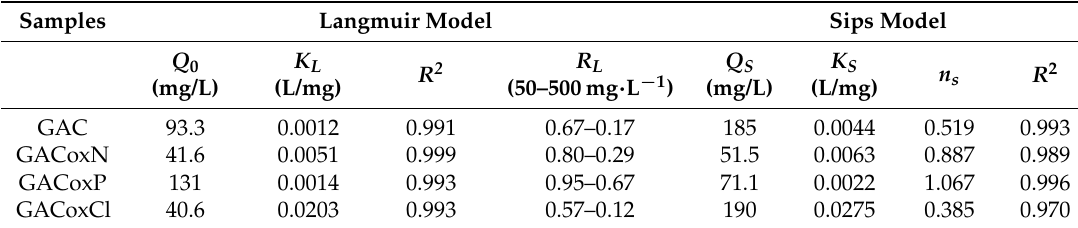
Table 4. Fitting parameters of Langmuir and Sips models for cadmium adsorption isotherms from aqueous solution on GAC, GACoxN, GACoxP, and GACoxCl, T = 25 ◦ C and pH =